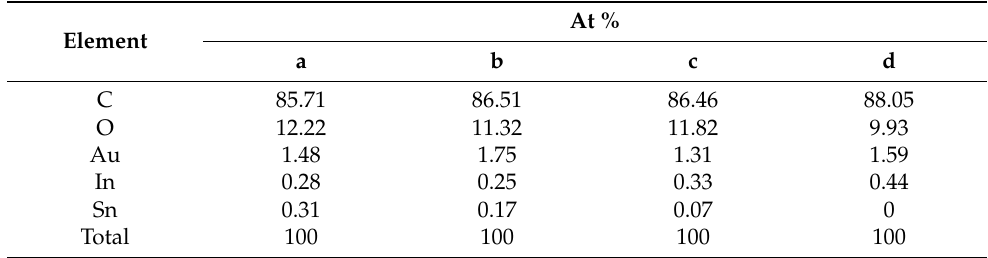
Table 3. Element content of the isolation line area in the site marked by circle in Figure 4 by EDS.